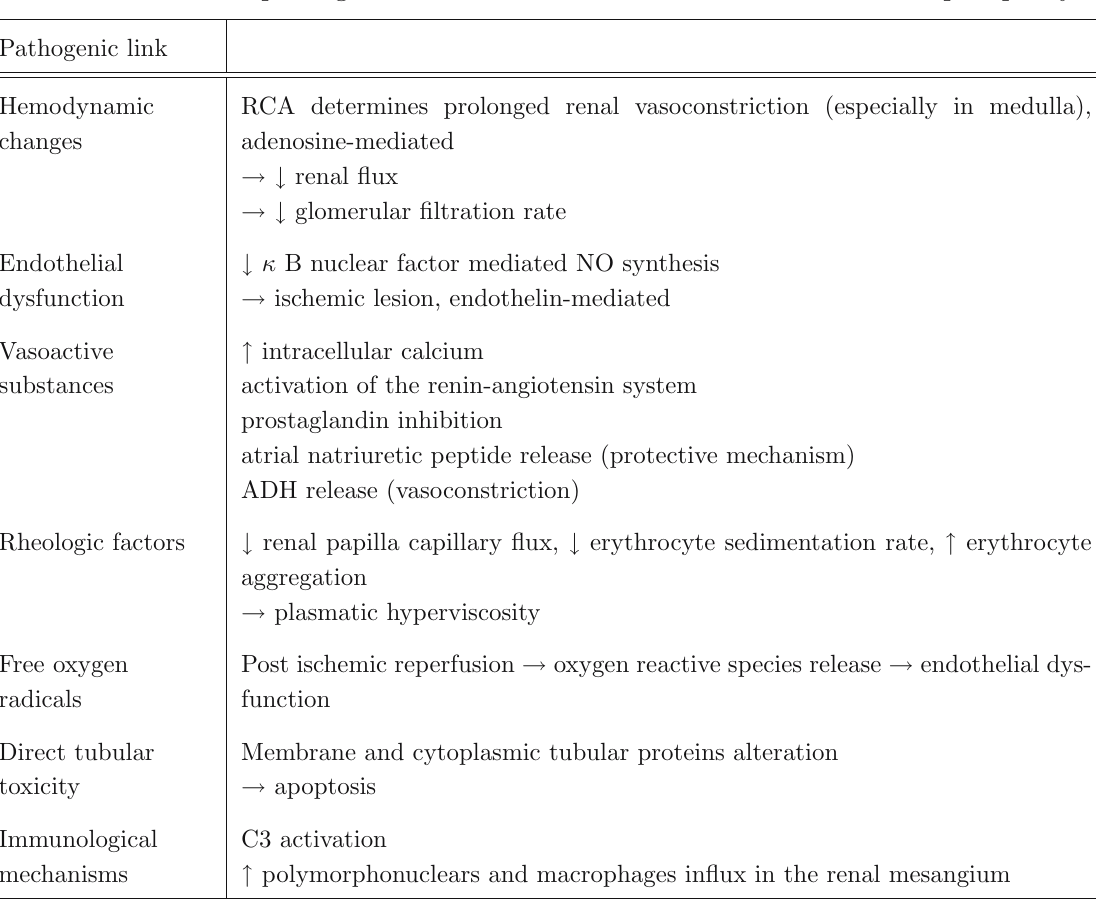
Table 3 The main pathogenic links involved in radiocontrast-induced